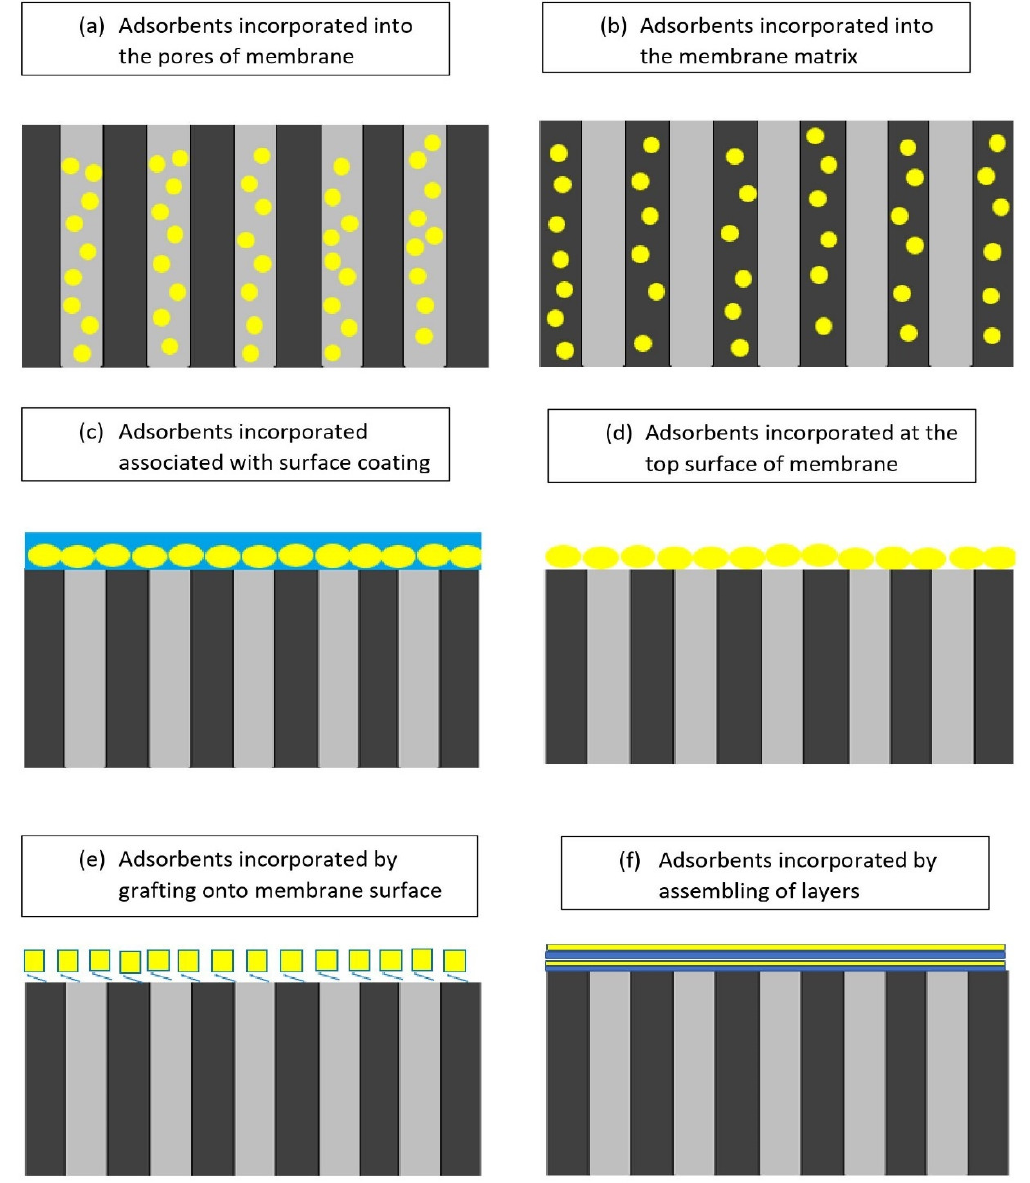
Figure 10. Positioning of adsorbents in the polymer matrix [118]. ( a ) Adsorbents incorporated into the pores of membrane. ( b ) Adsorbents incorporated into the membrane matrix. ( c ) Adsorbents incorporated associated with surface grafting. ( d ) Adsorbents incorporated at the top surface of mem- brane. ( e ) Adsorbents incorporated by grafting onto membrane surface. ( f ) Adsorbents incorporated by assembling of